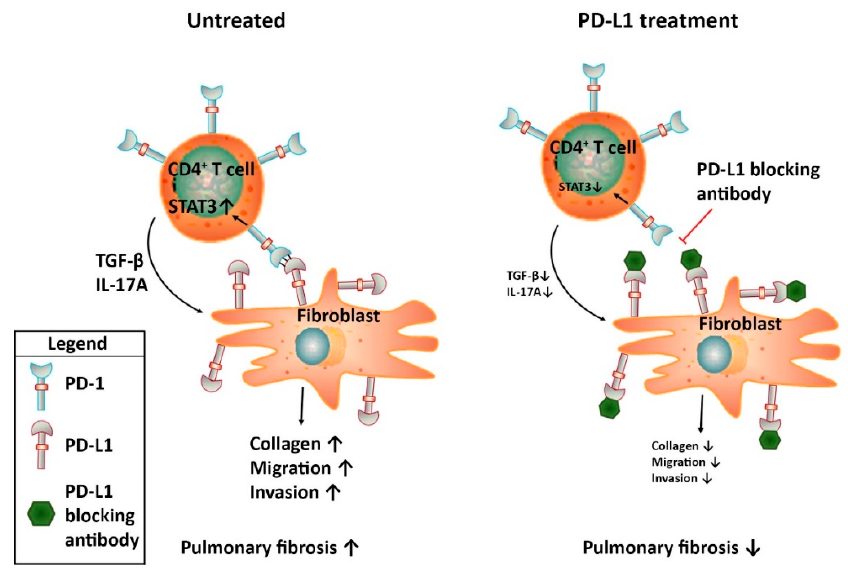
Figure 1. Schematic representation of the proposed mechanism by which the PD-1/PD-L1 axis contributes to pulmonary fibrosis. During IPF, PD-1 is expressed on CD4 + T cells whereas PD-L1 is expressed on fibroblasts. The subsequent cross-talk leads to STAT3-mediated IL17A and TGF- β production by the CD4 + T cells and pro-fibrotic responses by fibroblasts.